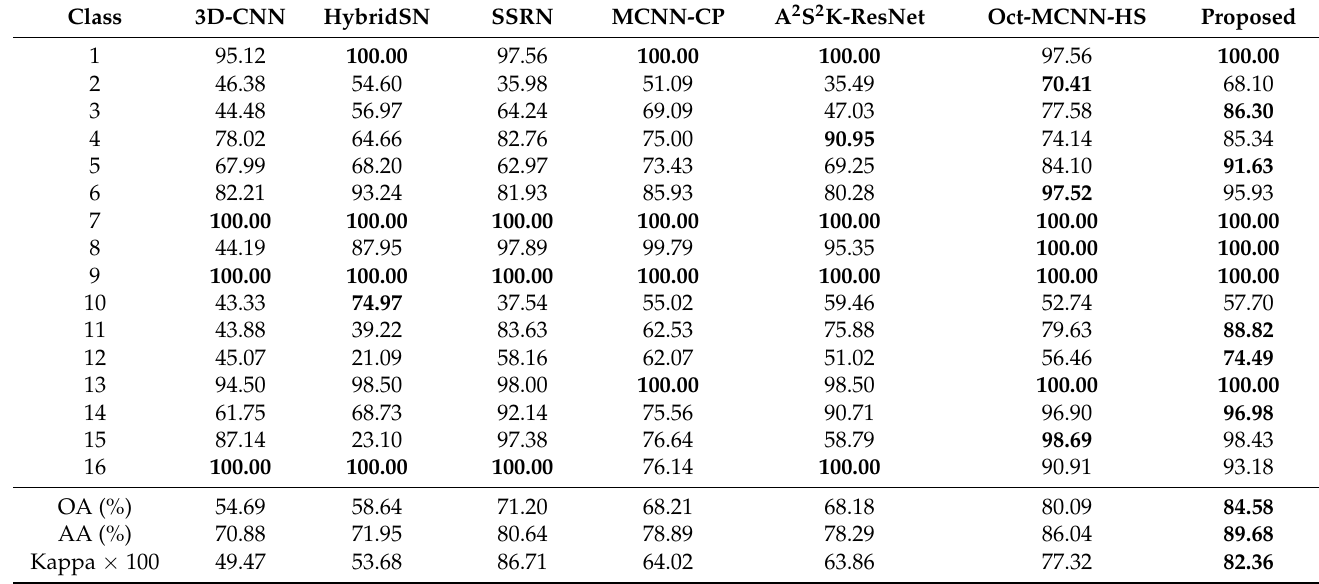
Table 7. The classification accuracy of different methods on the IP